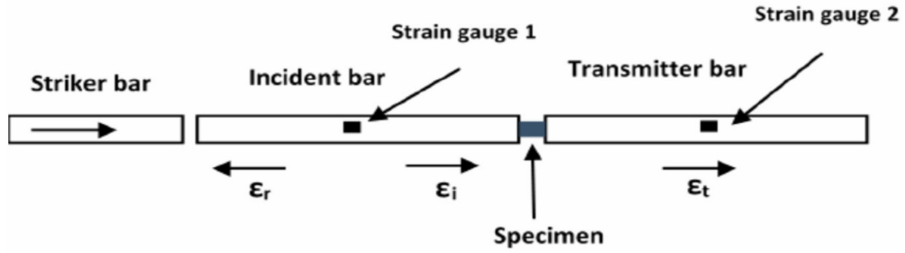
Figure 3. Schematic diagram of the SHPB apparatus in which symbols ε i , ε r and ε t denote the incident, reflected and transmitted